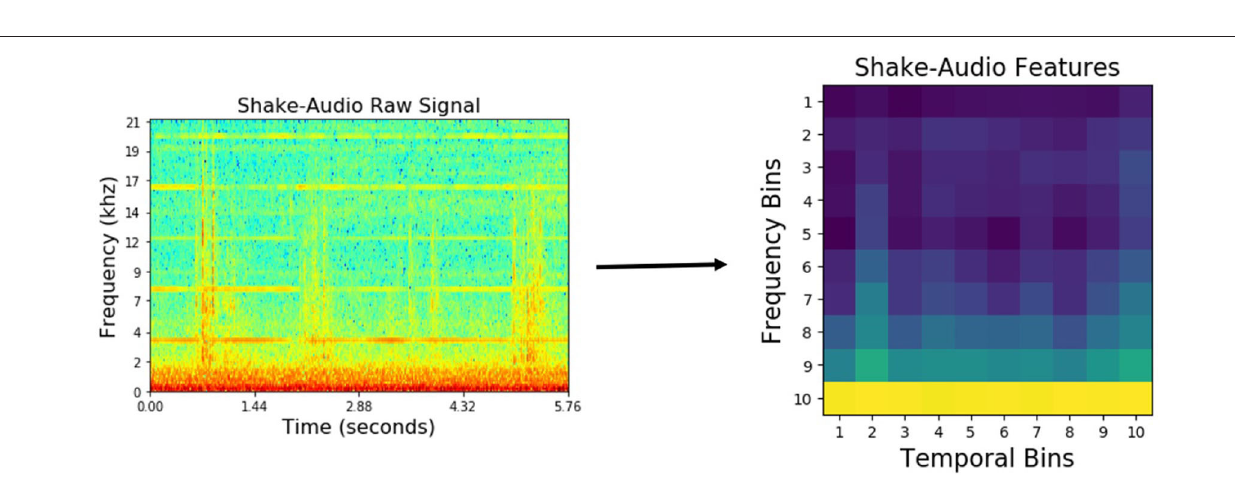
FIGURE 4 | Audio features using shake behavior performed on an object from the medicine bottles